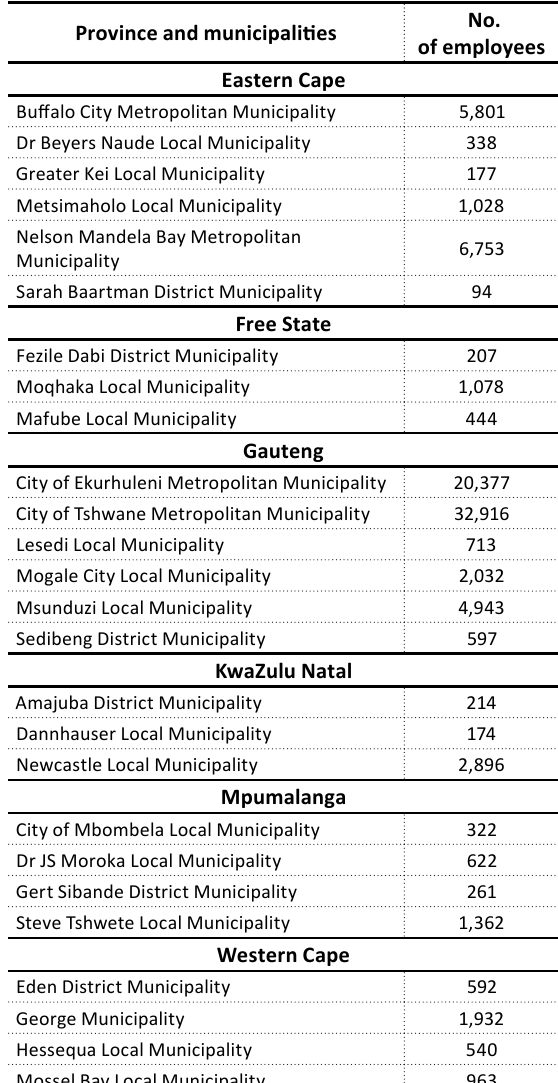
Table 2. Sampled municipalities per province Source: Adapted from the Department of Labor